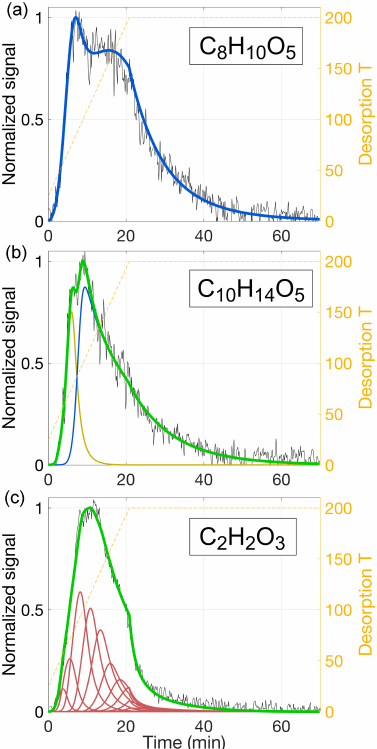
Figure 12. Examples of thermogram reproductions for three dif- ferent compositions: C 8 H 10 O 5 (a) , C 10 H 14 O 5 (b) , and C 2 H 2 O 3 (c) . All data are from the same aerosol desorption as data used for Figs. 9–11 (C 8 H 12 O 5 ). Experimental data are normalized and plotted in black; desorption temperature is shown as orange dashed lines (right-hand ordinates). Model results are presented as colored solid lines, with the color showing the source of the modeled sig- nal: beige for simple single-compound evaporation, blue when re- versible oligomerization is included and E d is independent from k d , 0 , and red for unidirectional thermal decomposition and fixed relation between E d and k d , 0 (Eq. 18). Sums are drawn in green. The model parameters used are given in Table